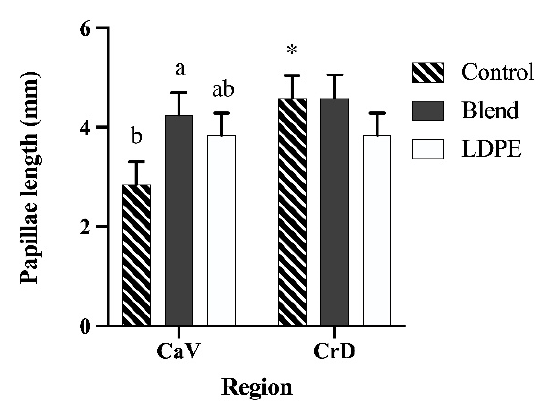
Figure 3. Papillae length in the caudal ventral (CaV) and cranial dorsal (CrD) regions of the reticulorumens of Holstein bull calves after 30 d of Control, Blend, or LDPE treatment administration. Treatment: p = 0.19. Region: p < 0.01. Treatment x Region: p < 0.01. a,b Different letters indicate differences between treatments within epithelium region. * Indicates a significant difference between regions within treatments. Data are shown as least-squared means of treatments within region (LSM ±